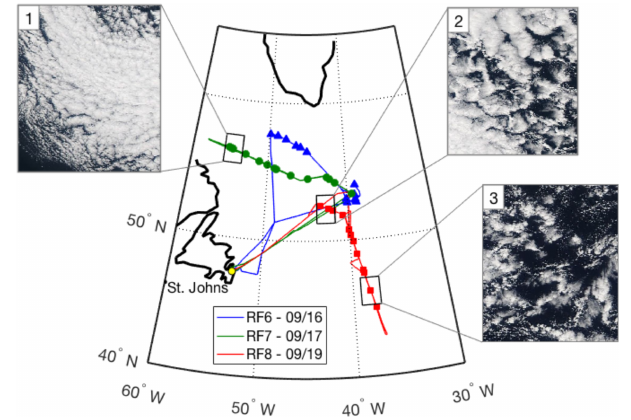
Figure 10. Flight tracks and cloud water sample locations during cold air outbreak case flown during NAAMES-3. Inset MODIS vis- ible images correspond to selected cloud water cases and highlight the range of cloud conditions.